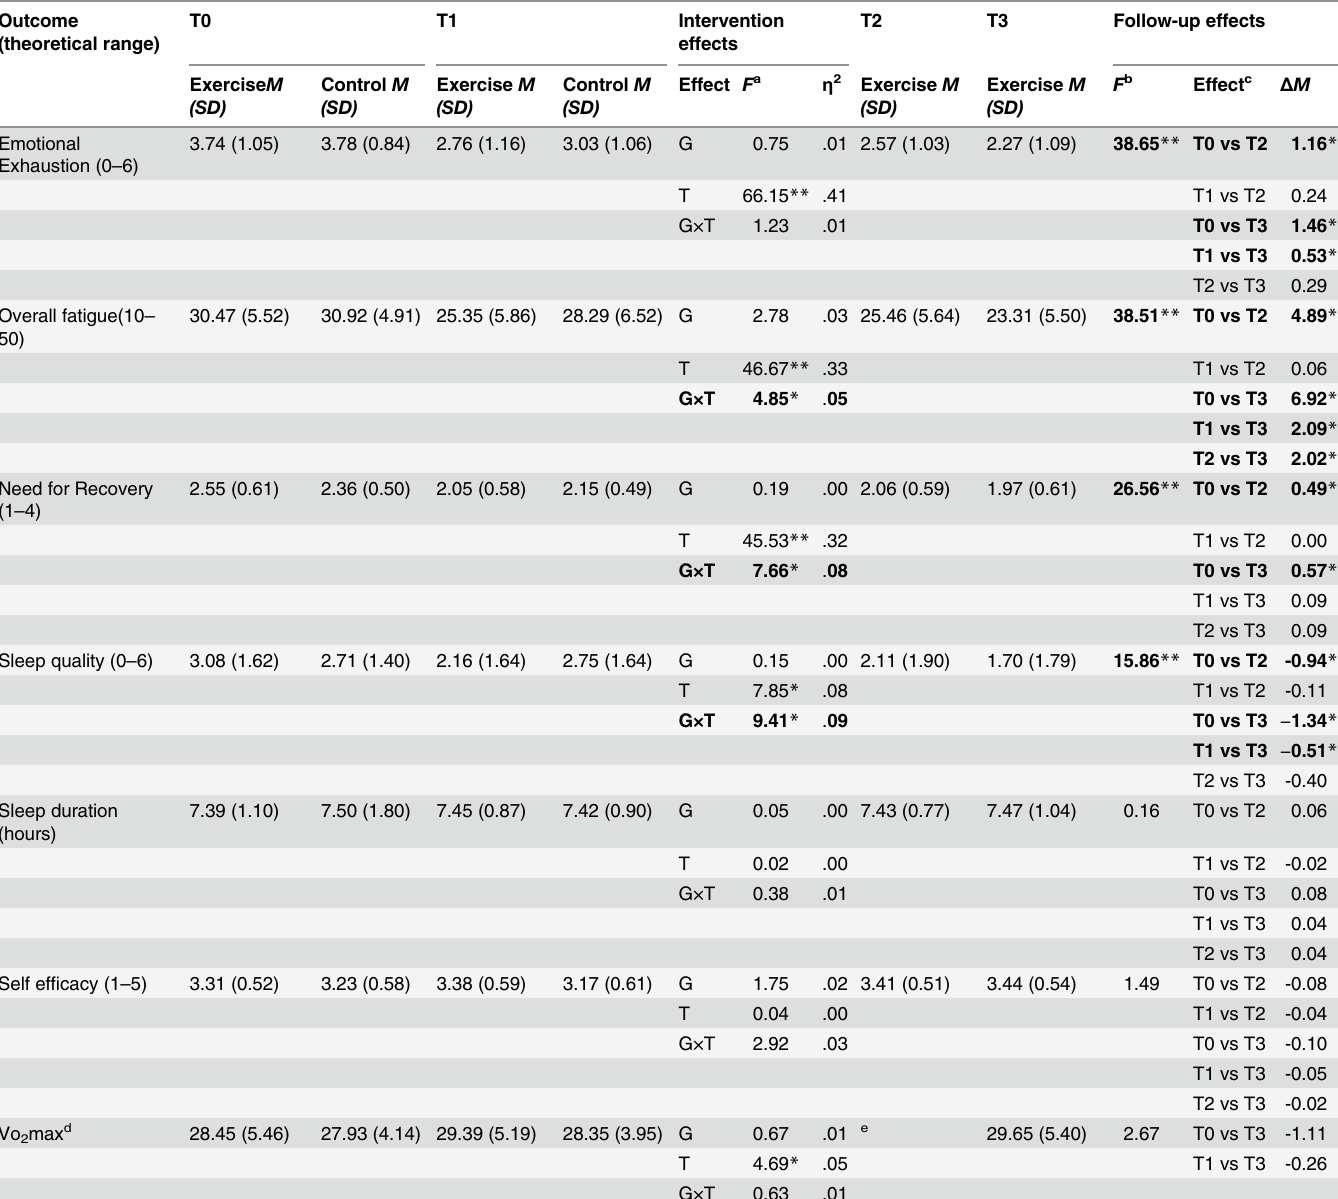
Table 2. Mean (SD) scores of emotional exhaustion, overall fatigue, need for recovery, sleep quality, sleep duration, self-efficacy, and physical fit- ness pre (T0) and post intervention (T1), at follow-up after 4 weeks (T2) and at follow-up after 12 weeks (T3) per condition. Outcome (theoretical